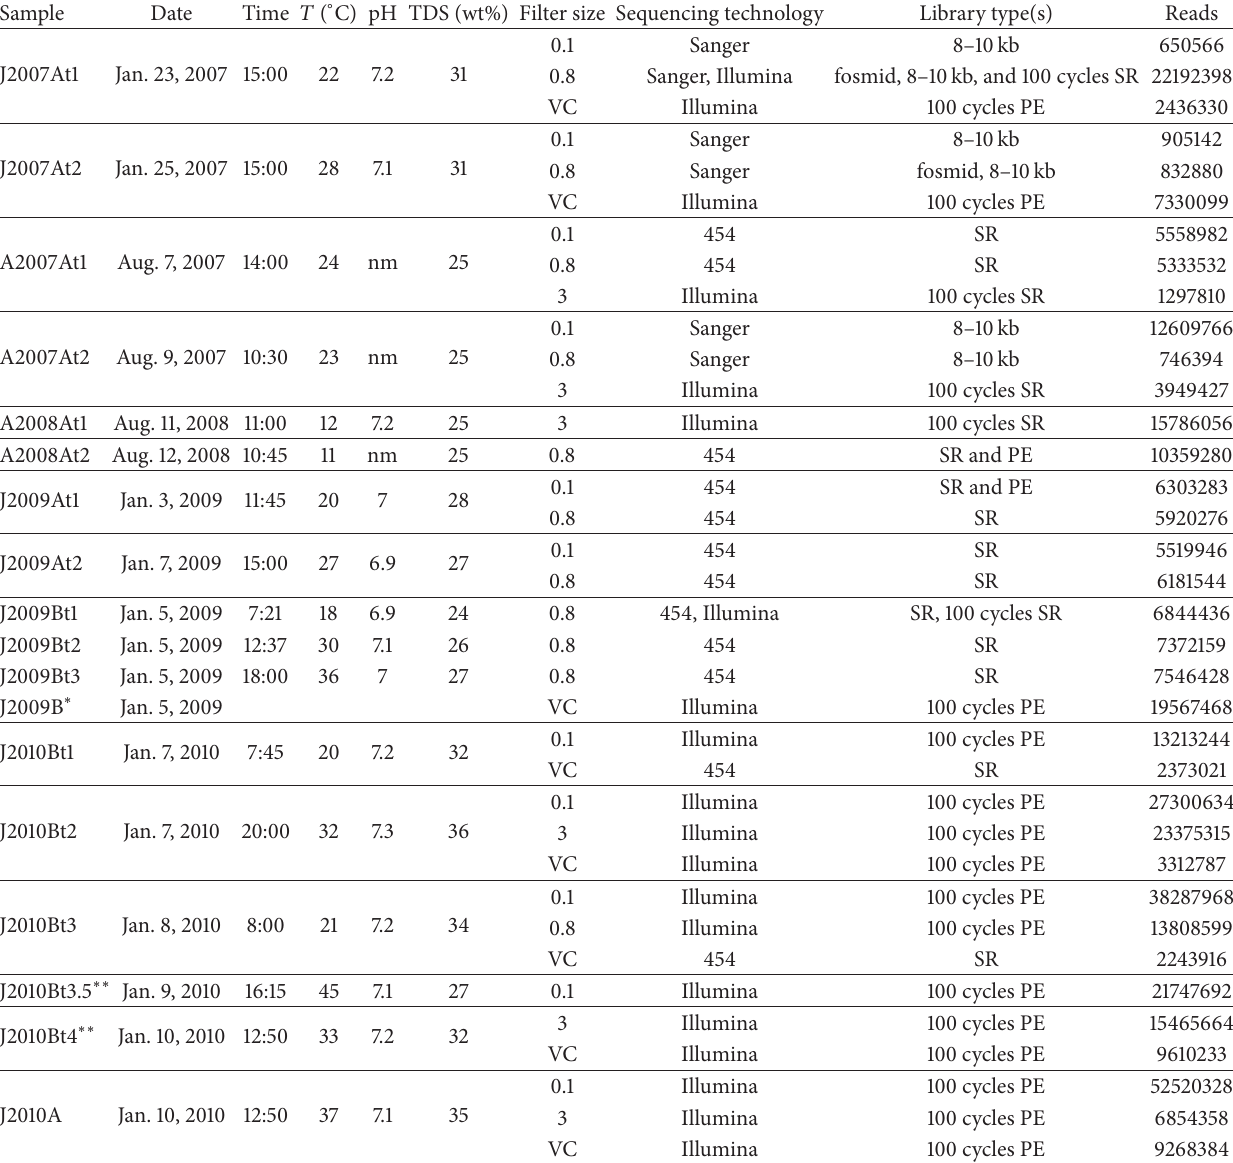
Table 1: Sequencing and sample information, all filter sizes and viral